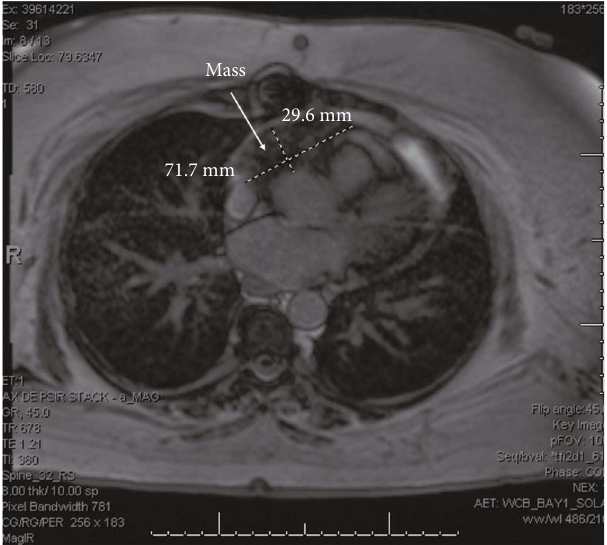
Figure 4: Follow-up magnetic resonance imaging demonstrated decreased size of the lesion posttreatment measuring 2 : 96 × 7 : 17